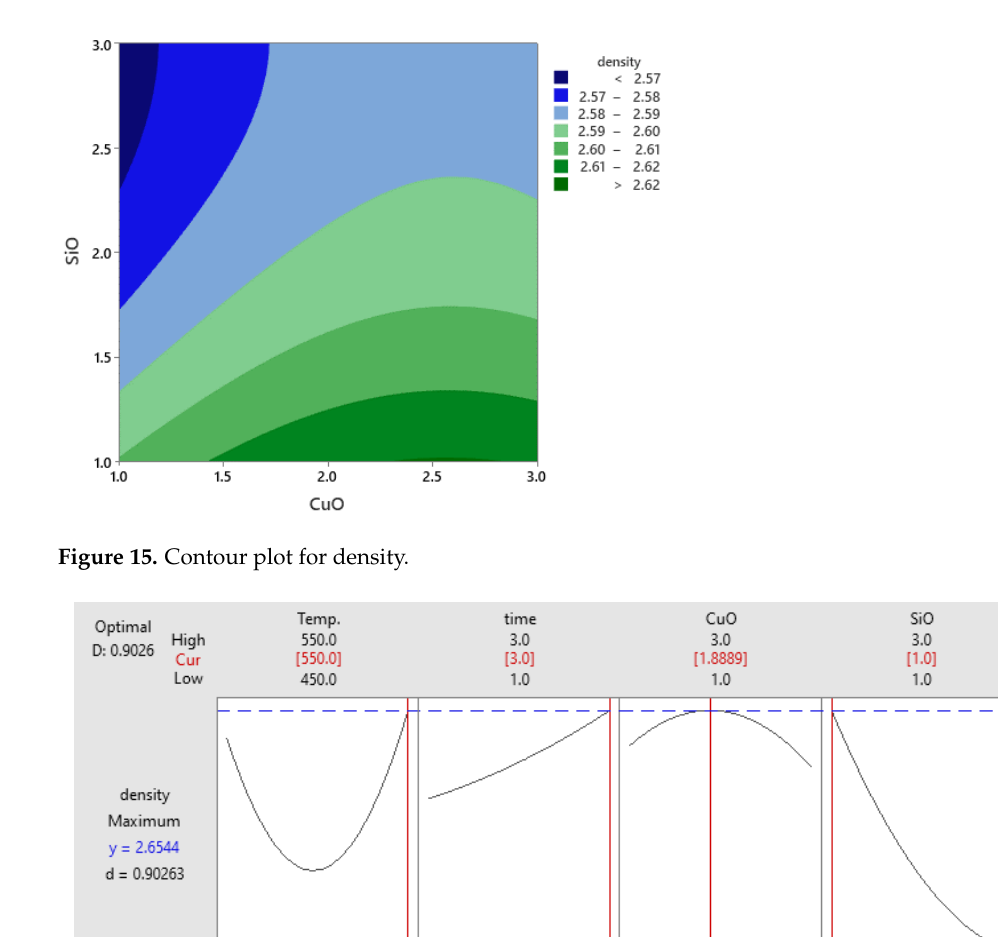
Figure 15. Contour plot for density.